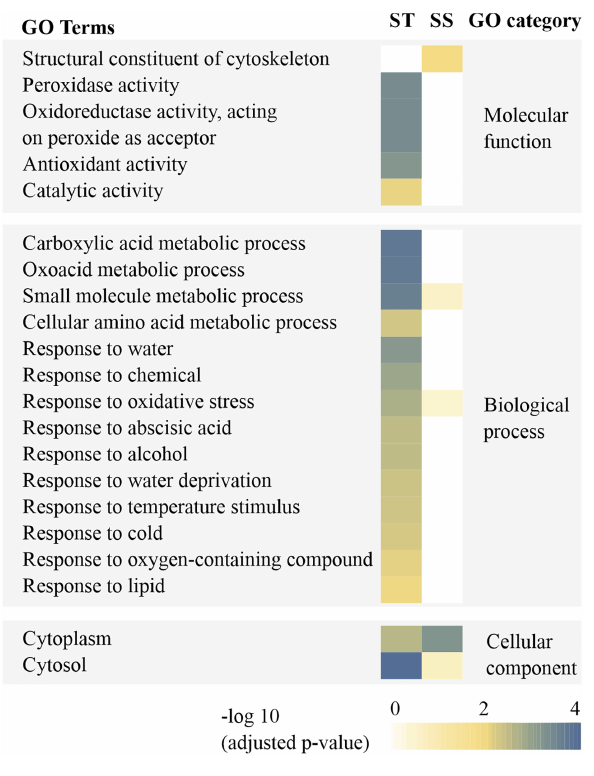
FIGURE 4 | Enrichment analysis for GO annotation of differentially abundant proteins (DAPs) resulting from imbibed embryos of aged storage-tolerant (ST) and storage-sensitive (SS) wheat accessions. GO categories were assigned as significant thresholds for correlation statistics ( p <